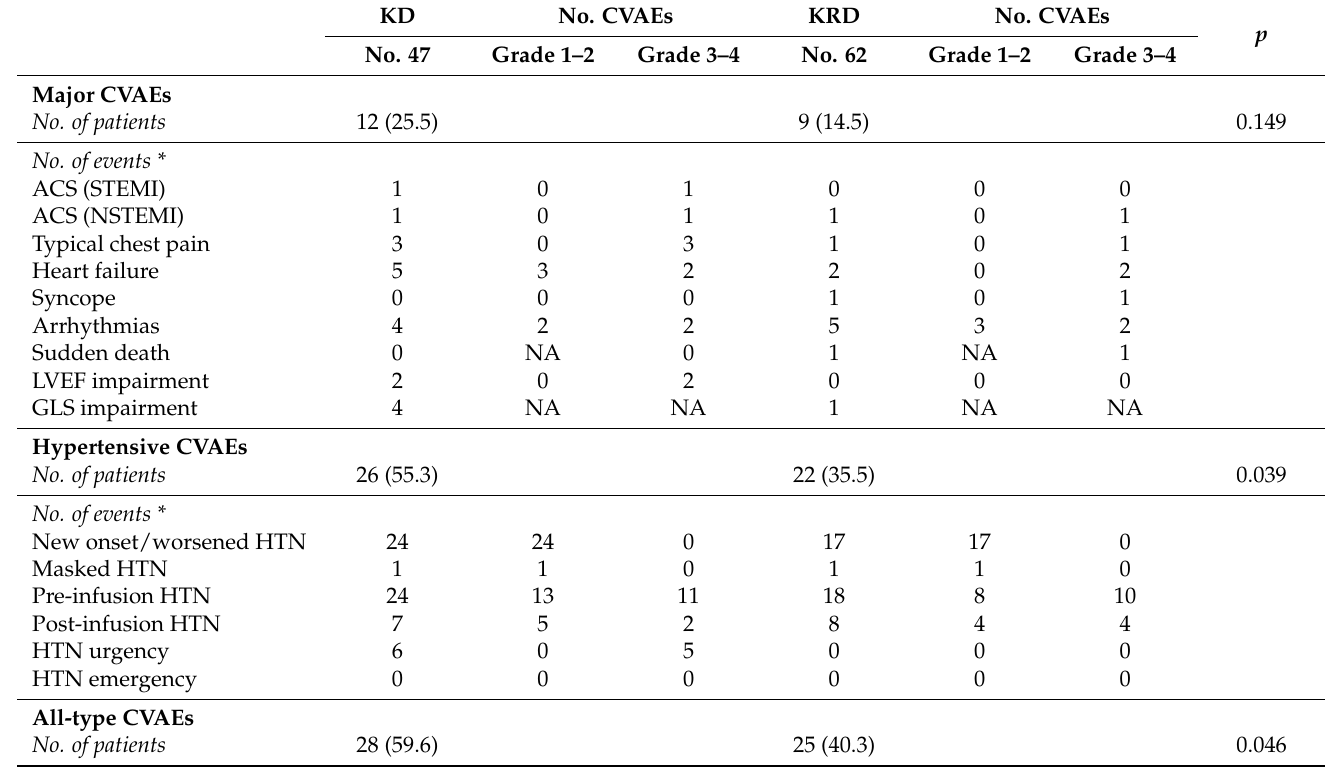
Table 2. Cardiovascular adverse events in Kd vs. KRd